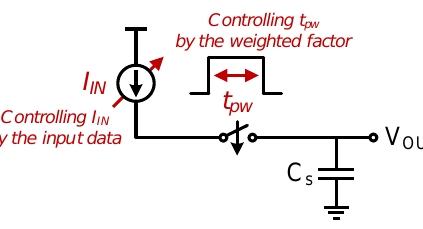
Figure 2. Proposed time-based analog multiplier.